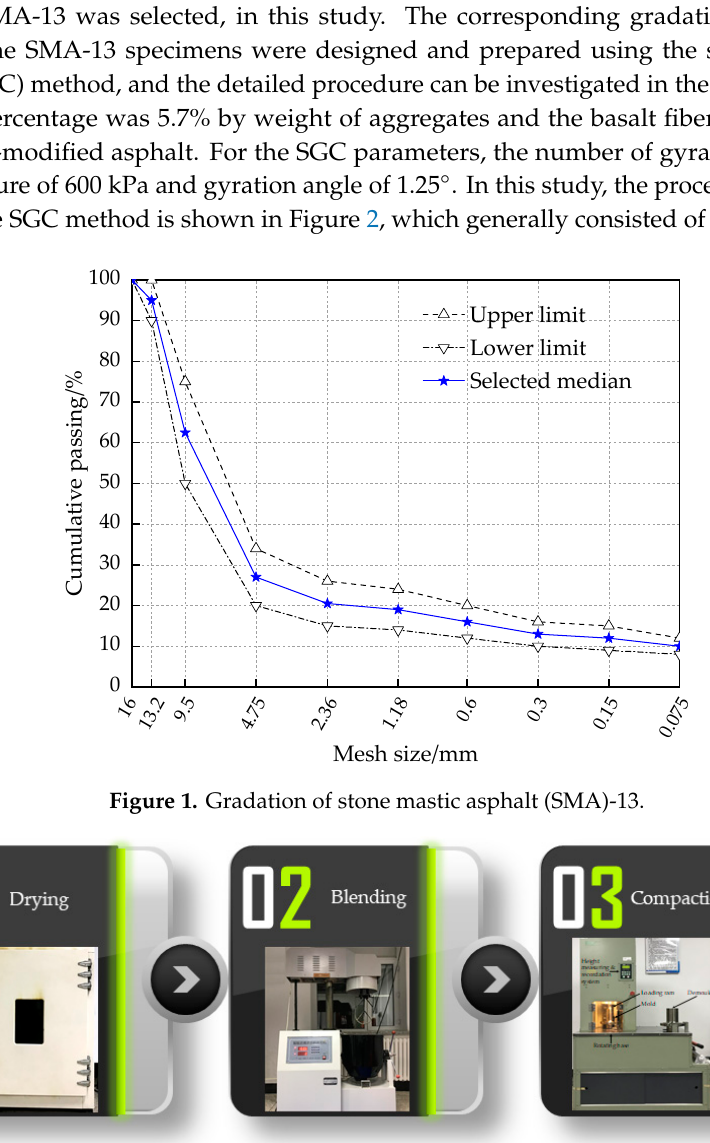
Figure 2. Preparation procedure of AC-13 by the superpave gyratory compaction (SGC) method.